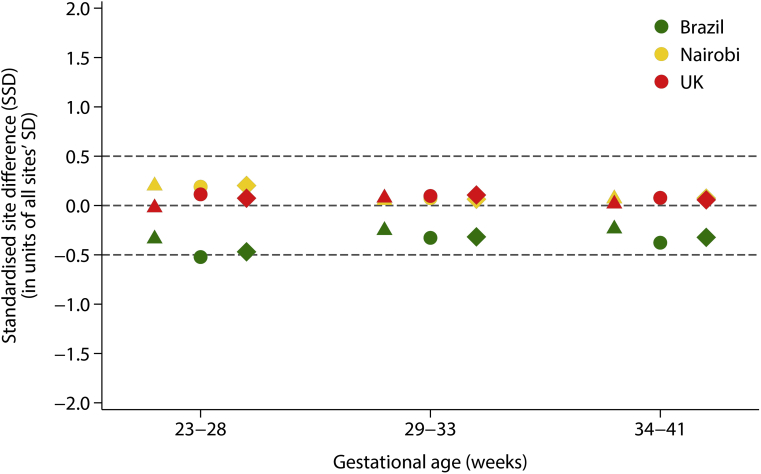
Standardized site differences (SSD) for three umbilical artery Doppler indicesSSDs for 3 umbilical artery Doppler indices for pulsatility index (triangles), resistance index (circles), and for the systolic/diastolic ratio (diamonds). SSDs were calculated as the site mean of each index minus the pooled mean divided by the standard deviation of all sites together, adjusted at the mean gestational age for the specified window.SSD, standardized site difference.Drukker et al. International gestational age-specific centiles for umbilical artery Doppler indices: a longitudinal prospective cohort study of the INTERGROWTH-21st Project. Am J Obstet Gynecol 2020.